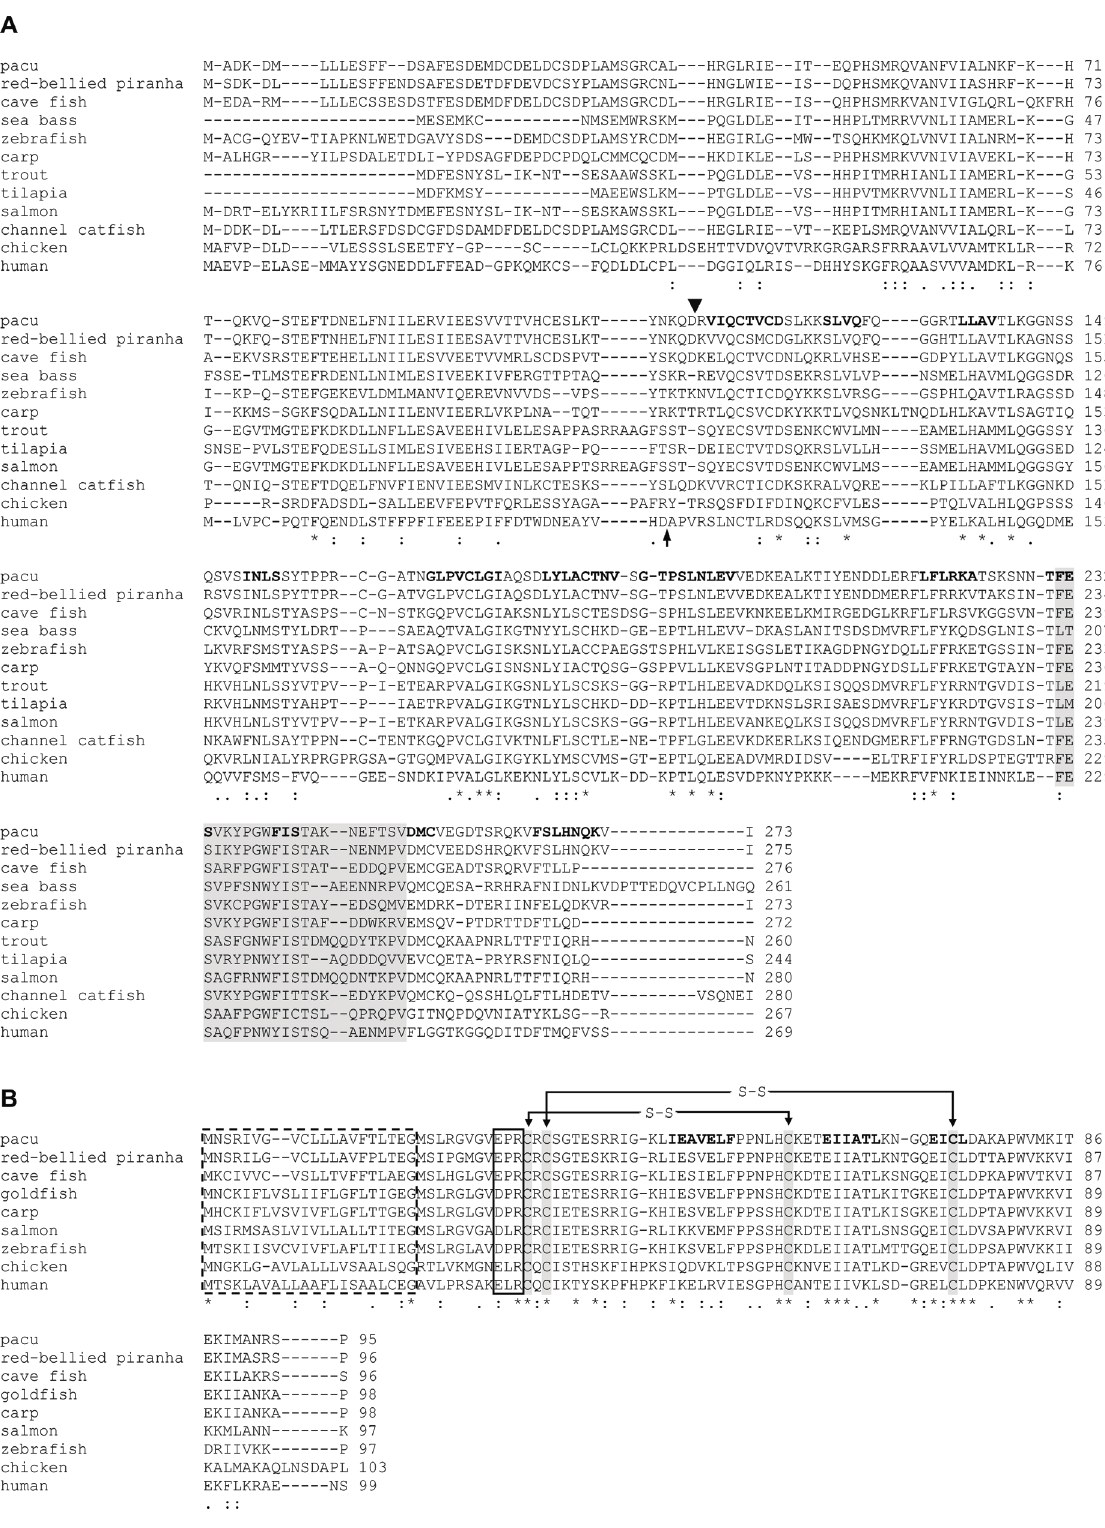
Figure 2 - Multiple alignment of the predicted amino acid sequence of pmIL-1 (cid:2) and pmIL-8 with other known vertebrates IL-1 (cid:2) and IL-8 proteins. Iden- tical(*)andsimilar(:or.)residuesareindicated.(A)Putativecaspase-1cleavagesitesareindicatedwithadownwardarrowheadforpacuIL-1 (cid:2) andwith an upward arrow for human IL-1 (cid:2) . Conserved (cid:2) -strand forming residues in the mature peptide are in bold. IL-1 family signature is indicated by grey shadow. (B) Signal peptide is indicated by a dotted box. The four conserved cysteines are highlighted by grey shadows. The EPR motif is indicated by a black box. Conserved (cid:2) -strand forming residues in the mature peptide are in bold. Disulfide bonds are indicated by lines connecting sulfur atoms of cysteine residues